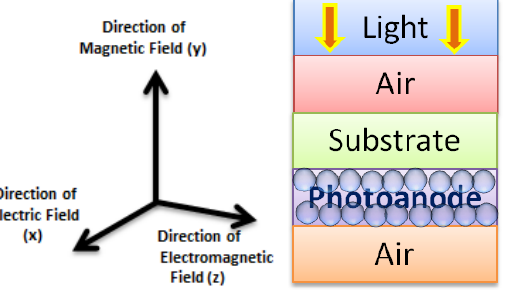
Figure 1. Schematic basic structure of the plasmonic dye-sensitized solar cell.